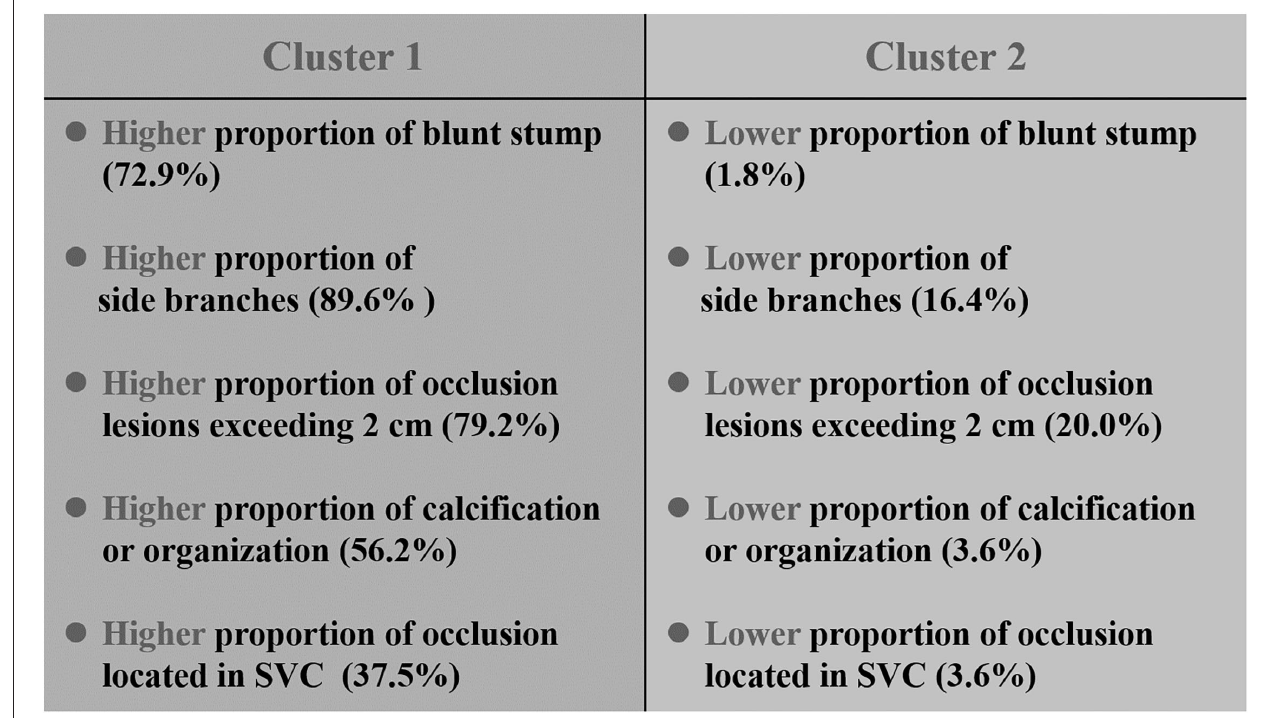
FIGURE 2 | Comparison of the typical characteristics of the two